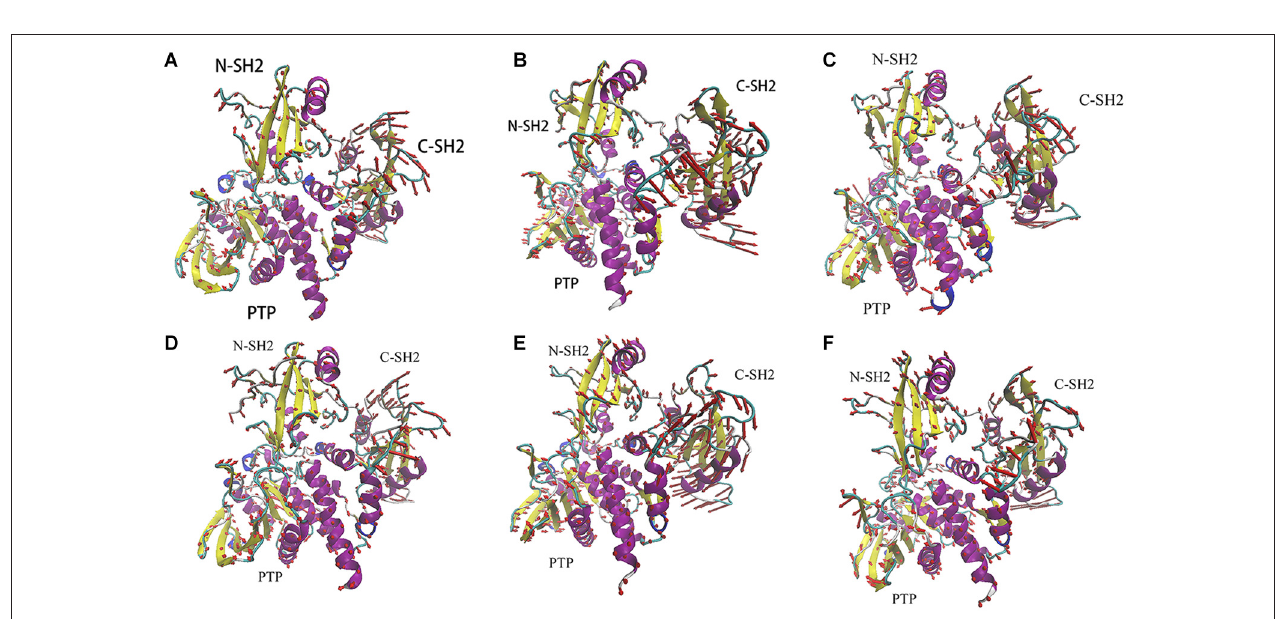
FIGURE 4 | The hydrogen bond frame between ITIM and N-SH2 domain (A) and the hydrogen bond frame between ITSM and C-SH2 domain (B) . The residues on ITIM or ITSM were identified by one letter (except PTR), and the residues on SHP2 were identified by three letters. The yellow dotted line means there is a hydrogen bond between the two residues.